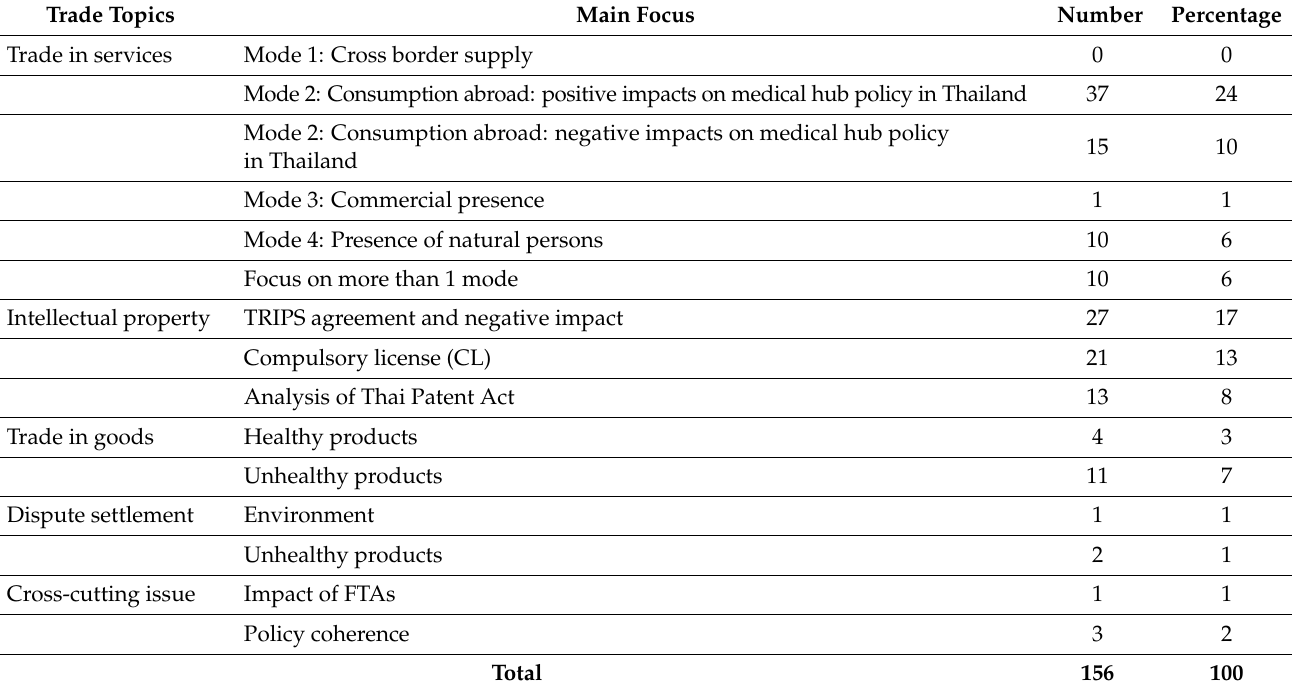
Figure 5. Proportion of studies focusing on different trade topics. Table 1. Numerical distribution by trade topic and the main focus of the included studies .